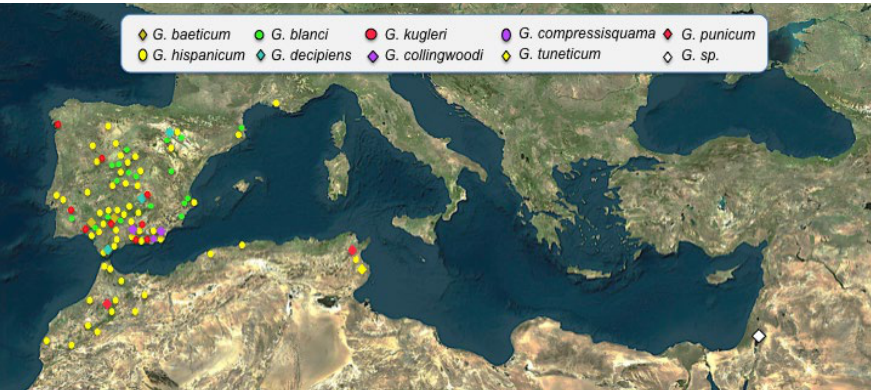
Figure 10. Disjunct distribution range of the species belonging to genus Goniomma . Note the presence of one species in Israel (citations from [71] are included; base map as in Figure 9).